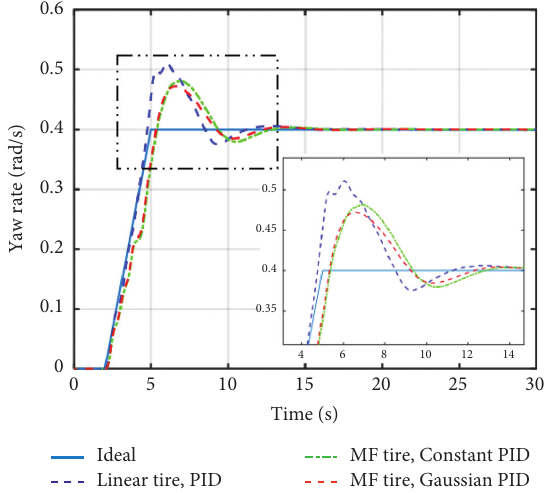
Figure 13: Comparison of yaw rate response.